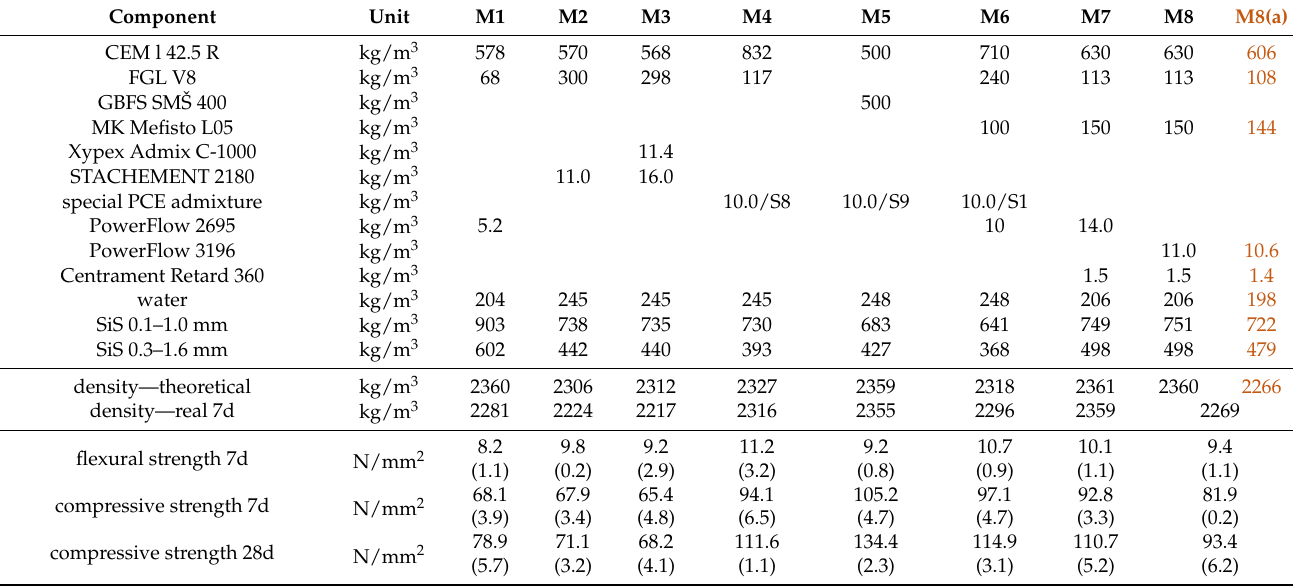
Table 2. Composition and parameters of all tested MMs (sample standard deviations are in brackets).